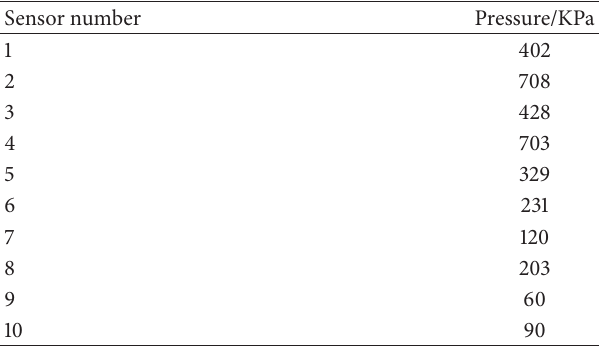
Table 4: Impact pressure distribution (scheme 1). Sensor number